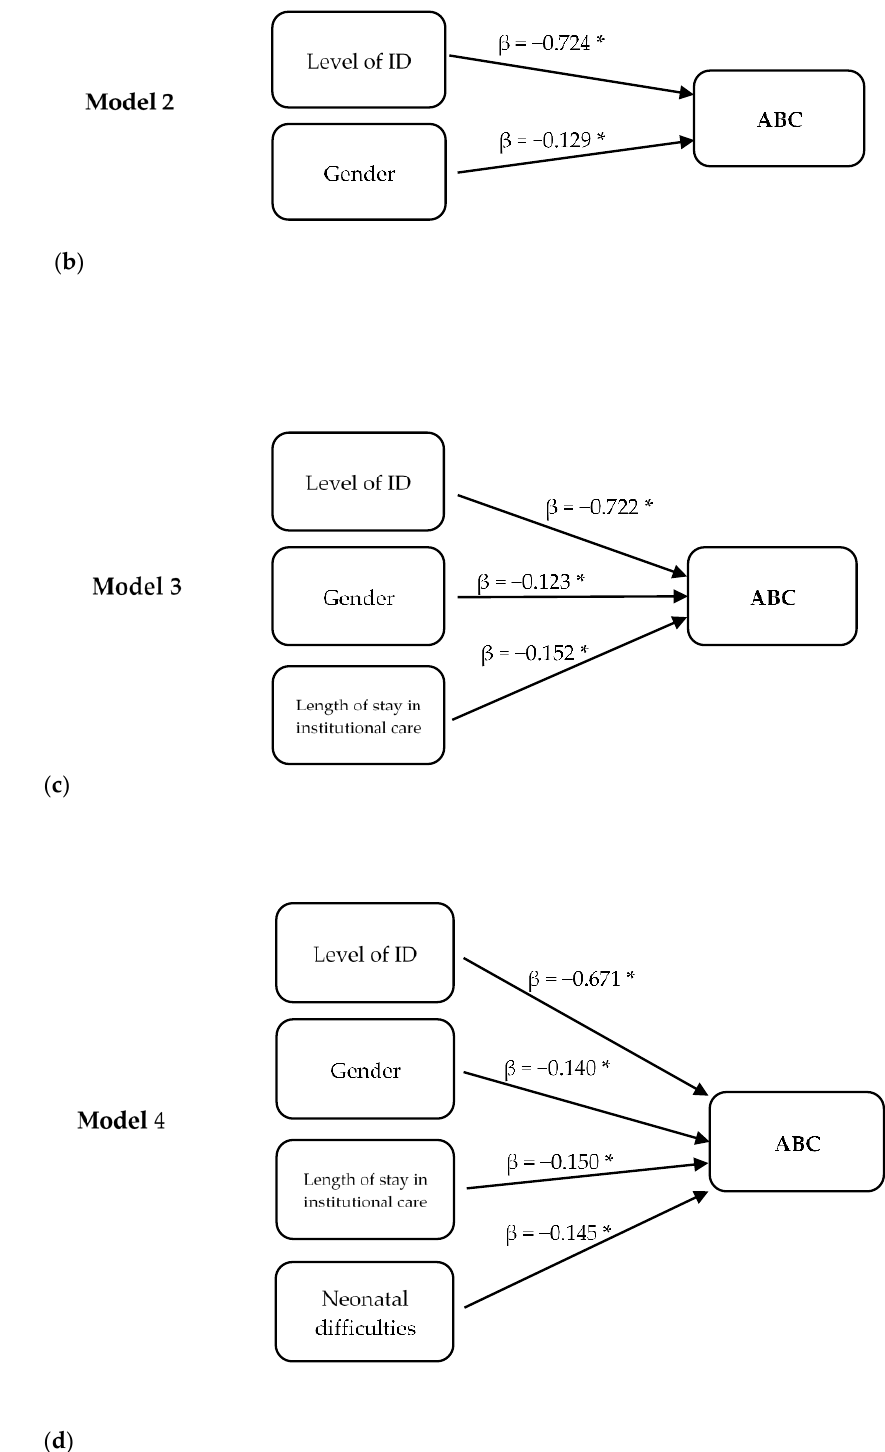
Figure 3. Hierarchical regression models for predicting ABC scores. Significant predictors were in four steps of regression: ( a ) Level of ID, ( b ) Level of ID and Gender of children, ( c ) Level of ID, Gender, and factors related to institutional care—Length of stay and Type of institutional care, ( d ) Level of ID, Gender, factors related to institutional care—Length of stay, Type of institutional care, and risk factors in development—Neonatal difficulties. * p < 0.05, ** p <